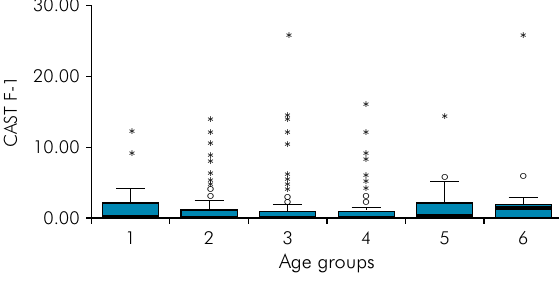
Figure 3. Means distribution of severity score as per CAST-F1, by age